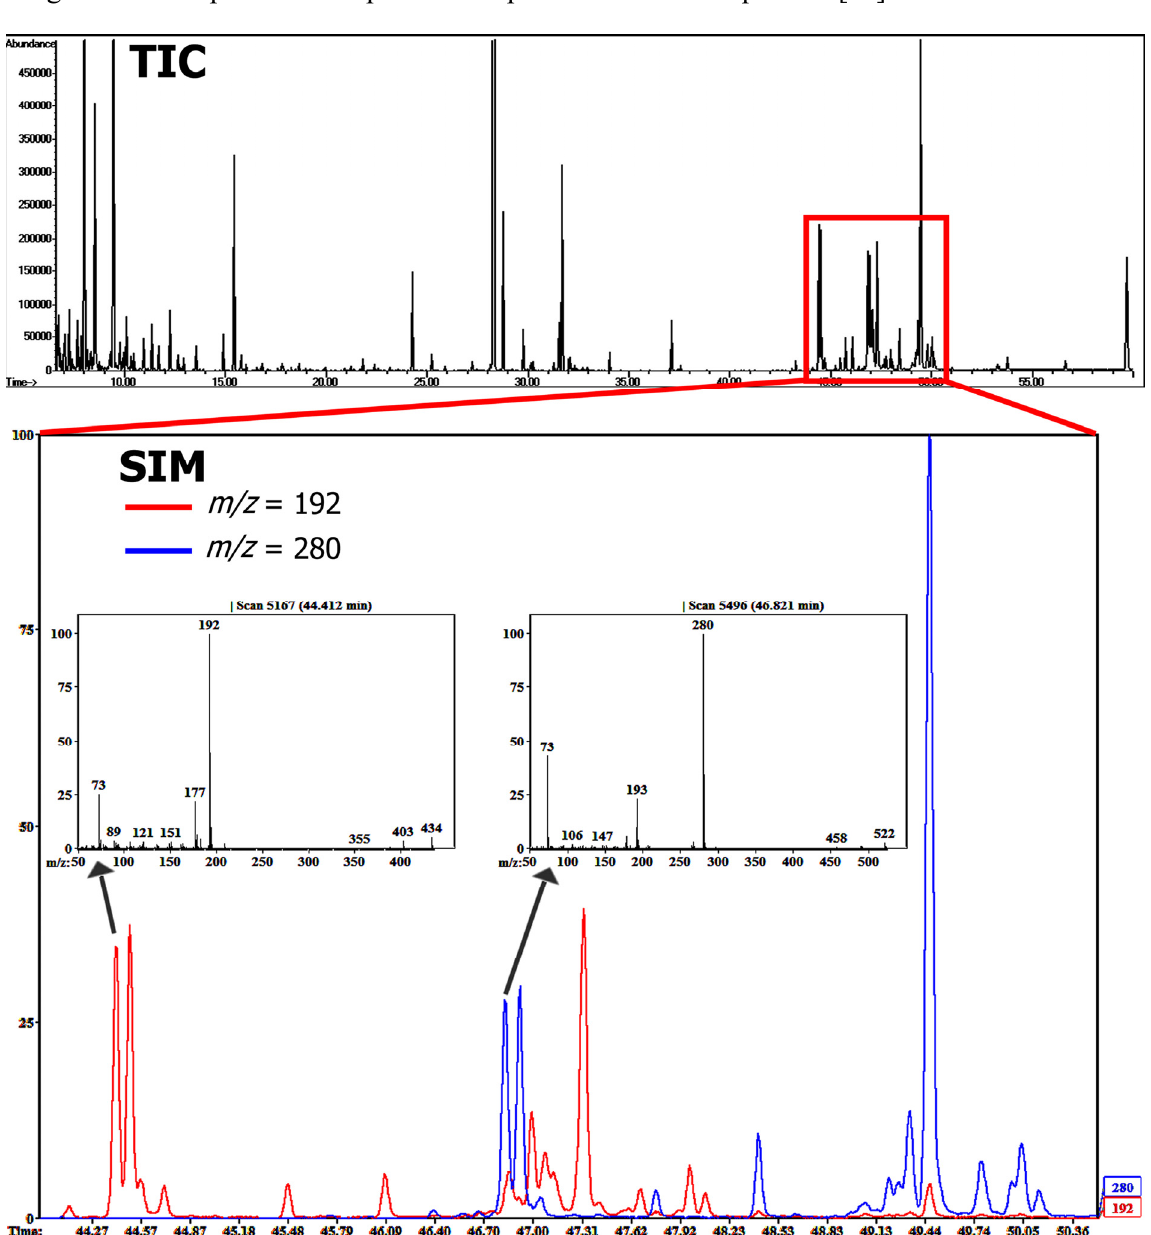
Figure 13. GC-MS chromatogram of the polar (phenolic) fraction of an example extra- virgin olive oil. The elution region of secoiridoids is highlighted, zooming in to a SIM chromatogram plot indicating separation patterns of ligstroside ( m/z = 192) and oleuropein ( m/z = 280) derivatives. MS spectra included in publicly available databases: [G]—Golm Metabolome Database; [H]—Human Metabolome Database; [M]—MassBank; [N]—NIST Chemistry